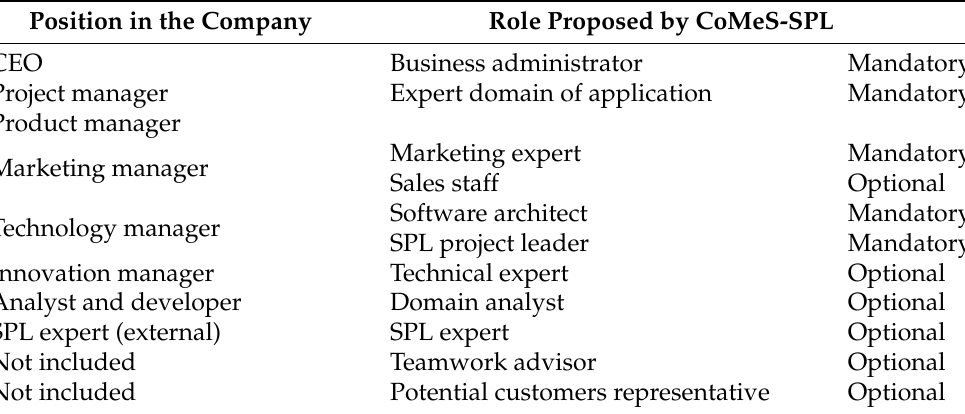
Table 5. Relation of company positions with the method roles.